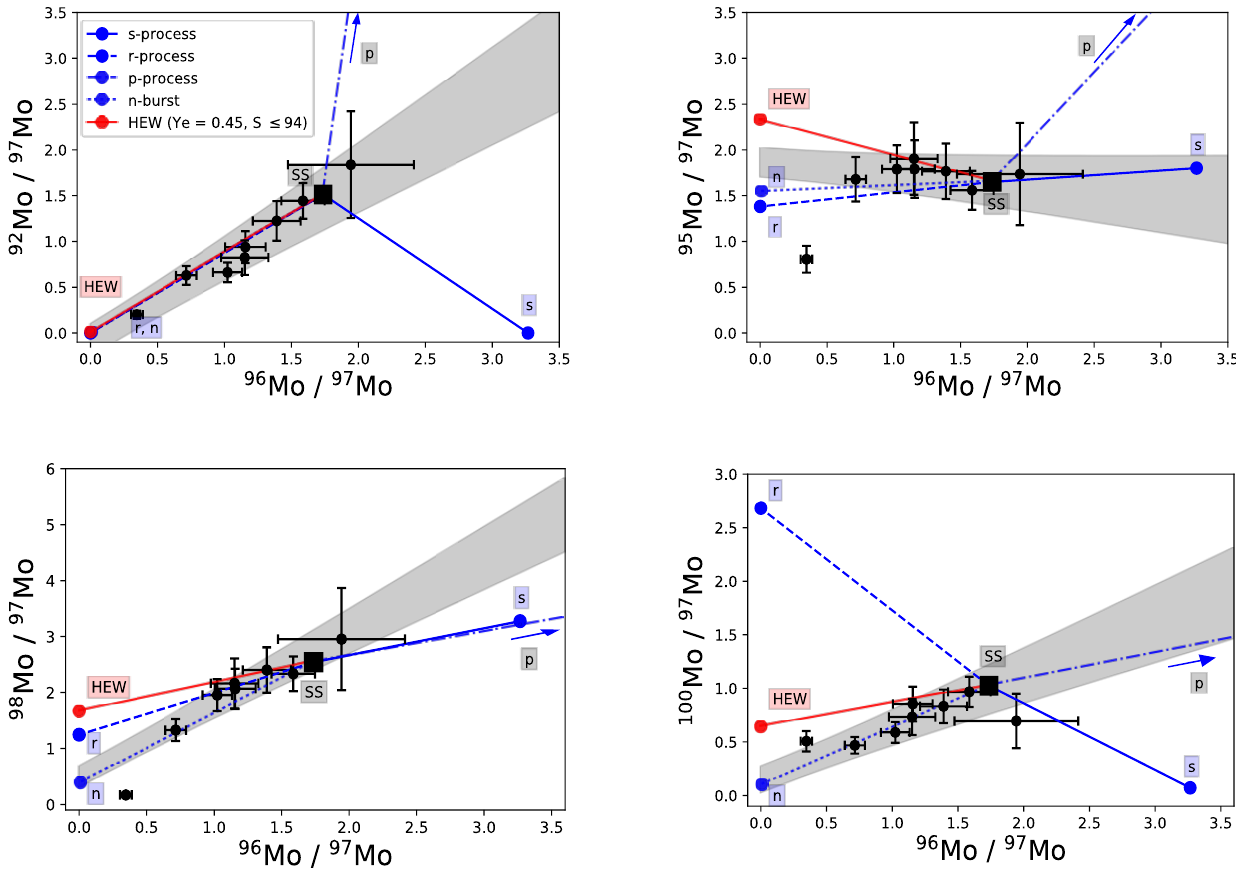
Figure 3. Molybdenum three-isotope plots for SiC-X grains overlaid with mixing lines for mixtures between various nucleosynthetic end-members and a S.S. component. Data uncertainties are 2 σ . The error bands obtained from the 2D data fits (as in Figure 2) are displayed as shaded areas. Filled circles represent end-member compositions.